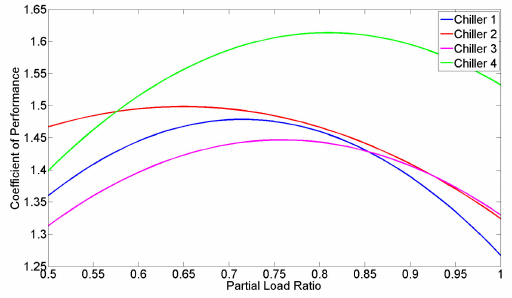
Figure 8. Chillers’ coefficients of performance (COPs) as a function of partial load